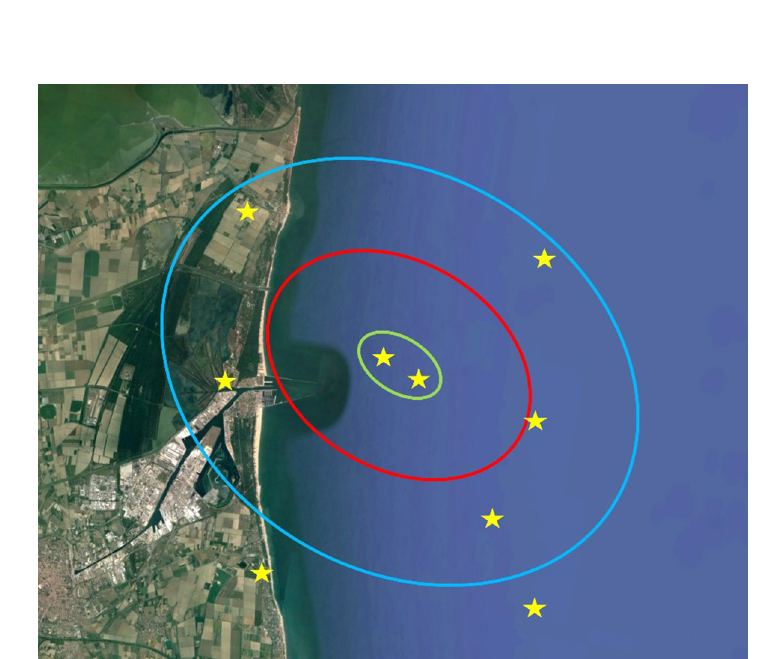
Fig. 19. – Example of a hybrid (onshore/offshore) microseismic network. Stars indicate the locations of seismic stations. Their number, azimuthal distribution and characteristics must comply with local guidelines, and are the result of a dedicated feasibility study. The green contour indicates the area of the depleted field, while the red and blue contours are at a distance of 5 and 10 km from the